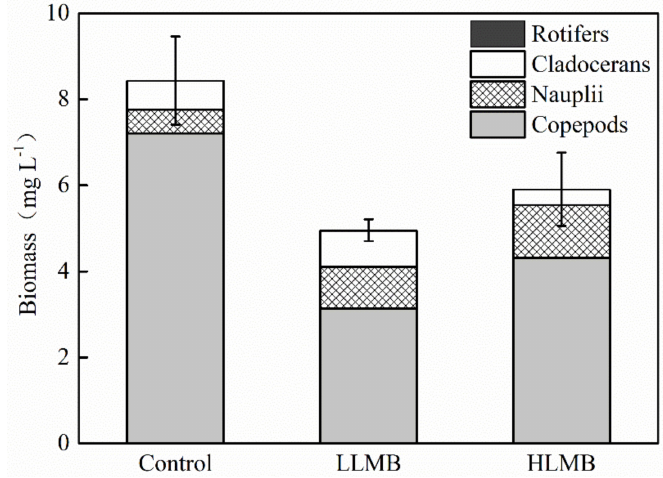
Figure 3. Biomass of zooplankton in different treatments. Factor was LMB (0, 425 g m − 2 , and 850 g m − 2 ). The values represented a standard deviation ( n = 4).